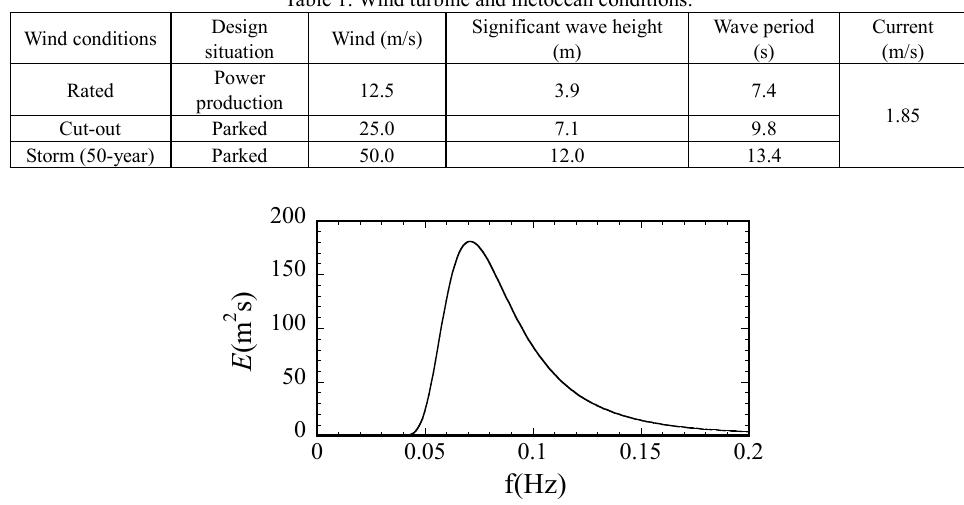
Fig. 4 Bretschneider-Mitsuyasu spectrum under storm